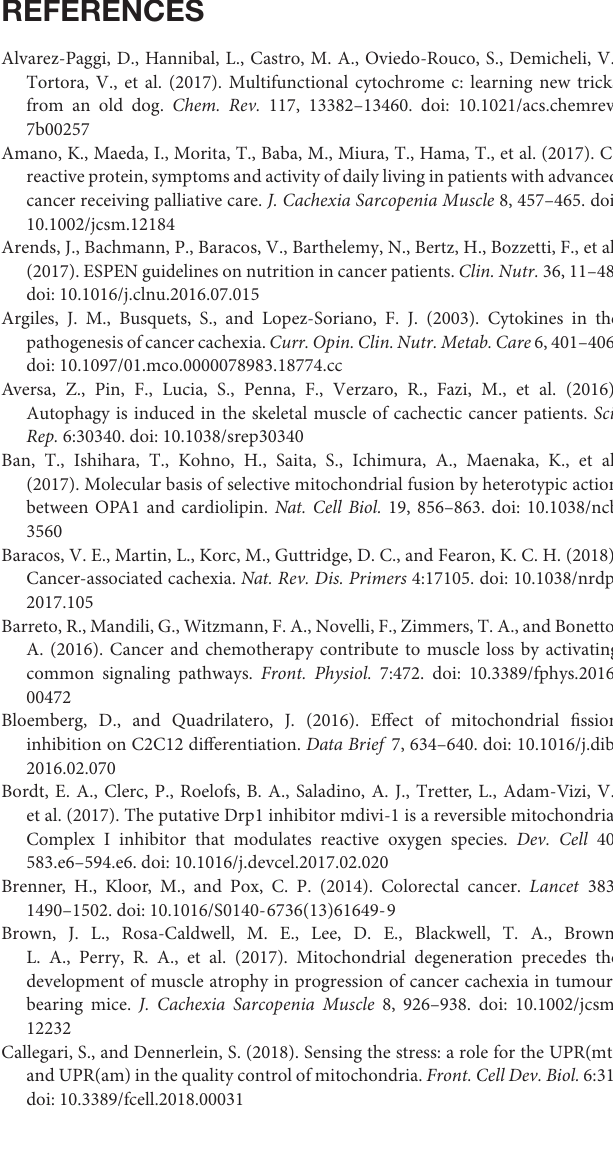
Supplementary Figure 1 | (A) Typical images of C2C12 myotube co-cultured with CM for 48 h. (B) Quantification of myotube diameter. (C) Level of MyoD and MyoG by western blot. (D) Quantification of MyoD and MyoG # P < 0.05 vs. HS group (E) Level of MyoD and MyoG by western blot. (F) Quantification of complex I ∗ P < 0.05 Control: myotube cultured in DMEM of 2% HS CM (conditional